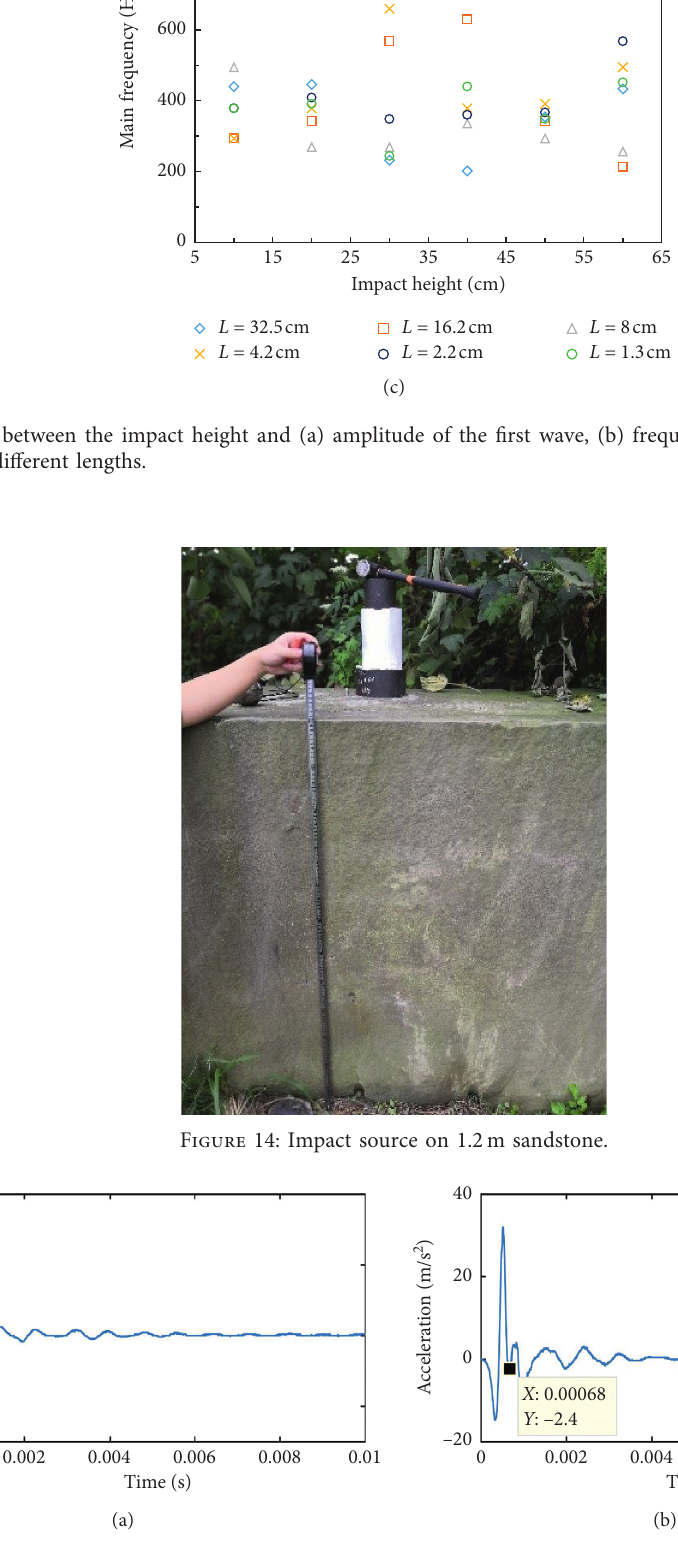
Figure 15: Time-domain waveforms received by the acceleration sensor on sandstone surface: (a) no reflected wave received; (b) reflected wave